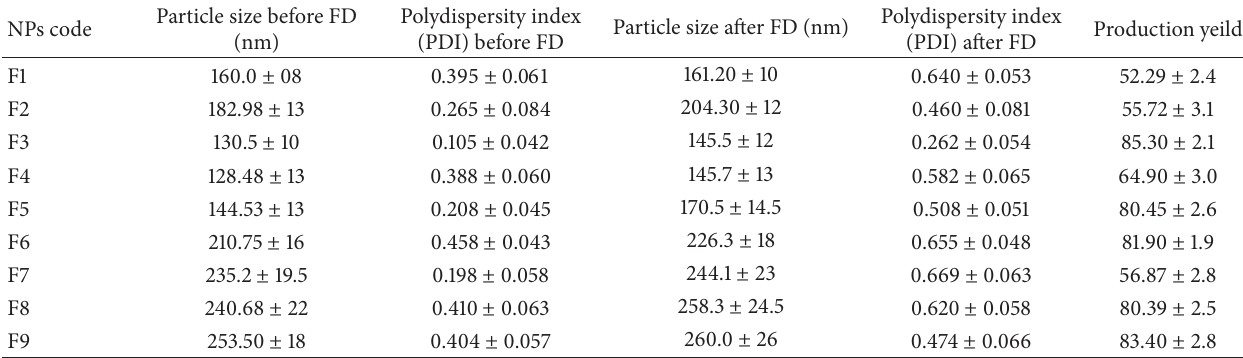
Table 4: Particle size, PDI of CsA loaded NPs after and before freeze drying (FD) and production yield of NPs.